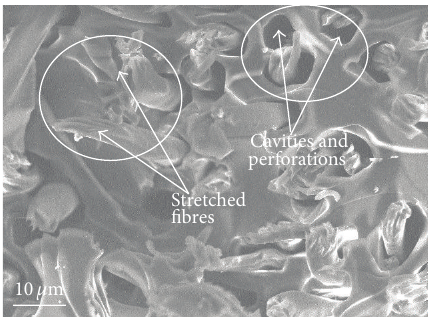
Figure 16: SEM micrograph shows the fractured surface of the interwoven hybrid composite after impact test.